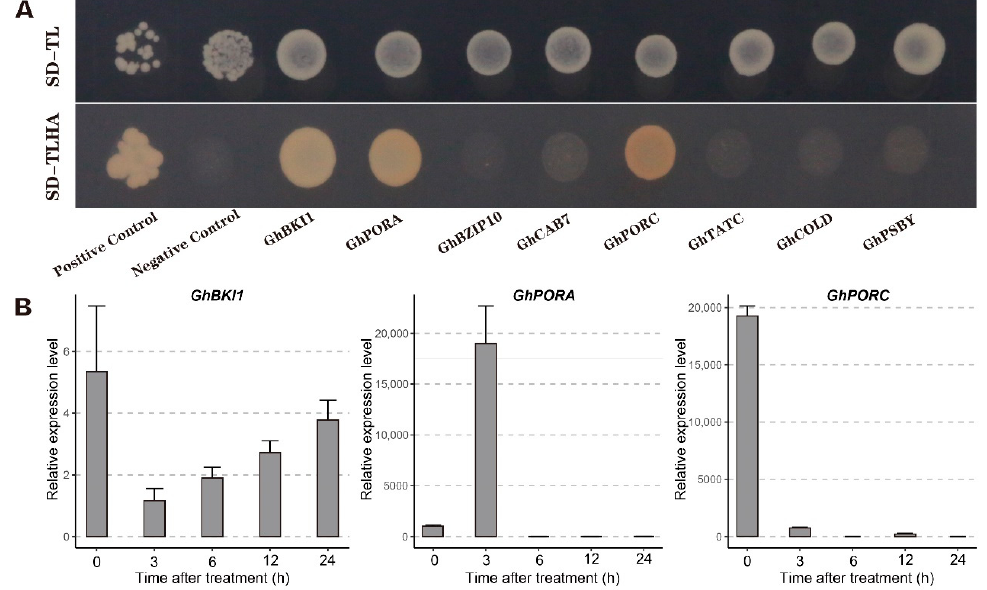
Figure 10. Interaction of GhTIP1;1-like with candidate proteins using a yeast two-hybrid assay. ( A ) Yeast two-hybrid analysis of the interaction between GhTIP1;1-like and other candidate proteins. The combination of the pGADT7-large T and pGBKT7-p53 plasmids was used as the positive control, and the combination of the pGADT7-large T and pGBKT7-laminC plasmids was used as a negative control. ( B ) Expression patterns of genes encoding potential proteins that interact with GhTIP1;1-like under cold treatments. Each experiment was repeated three times, with the bar representing the standard error